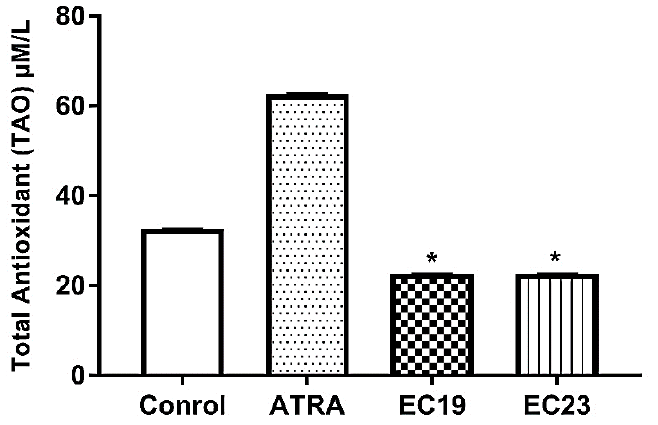
Figure 7. Total antioxidant activity (TAO) of retinoid-treated Caco-2 cells using IC 50 dose for 24 h. Both EC19 and EC23 induced a significant reduction in the total antioxidants compared to control (treated with 0.1% DMSO). Data is represented as the mean of TOA ± SEM, n = 3. * p < 0.05.